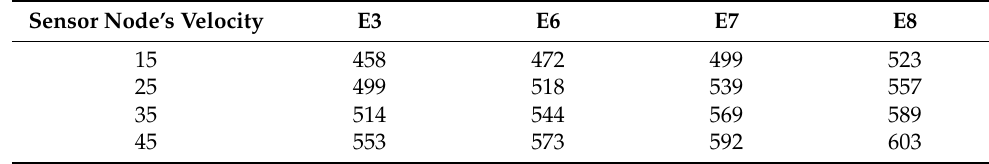
Table 7. Routing delay.